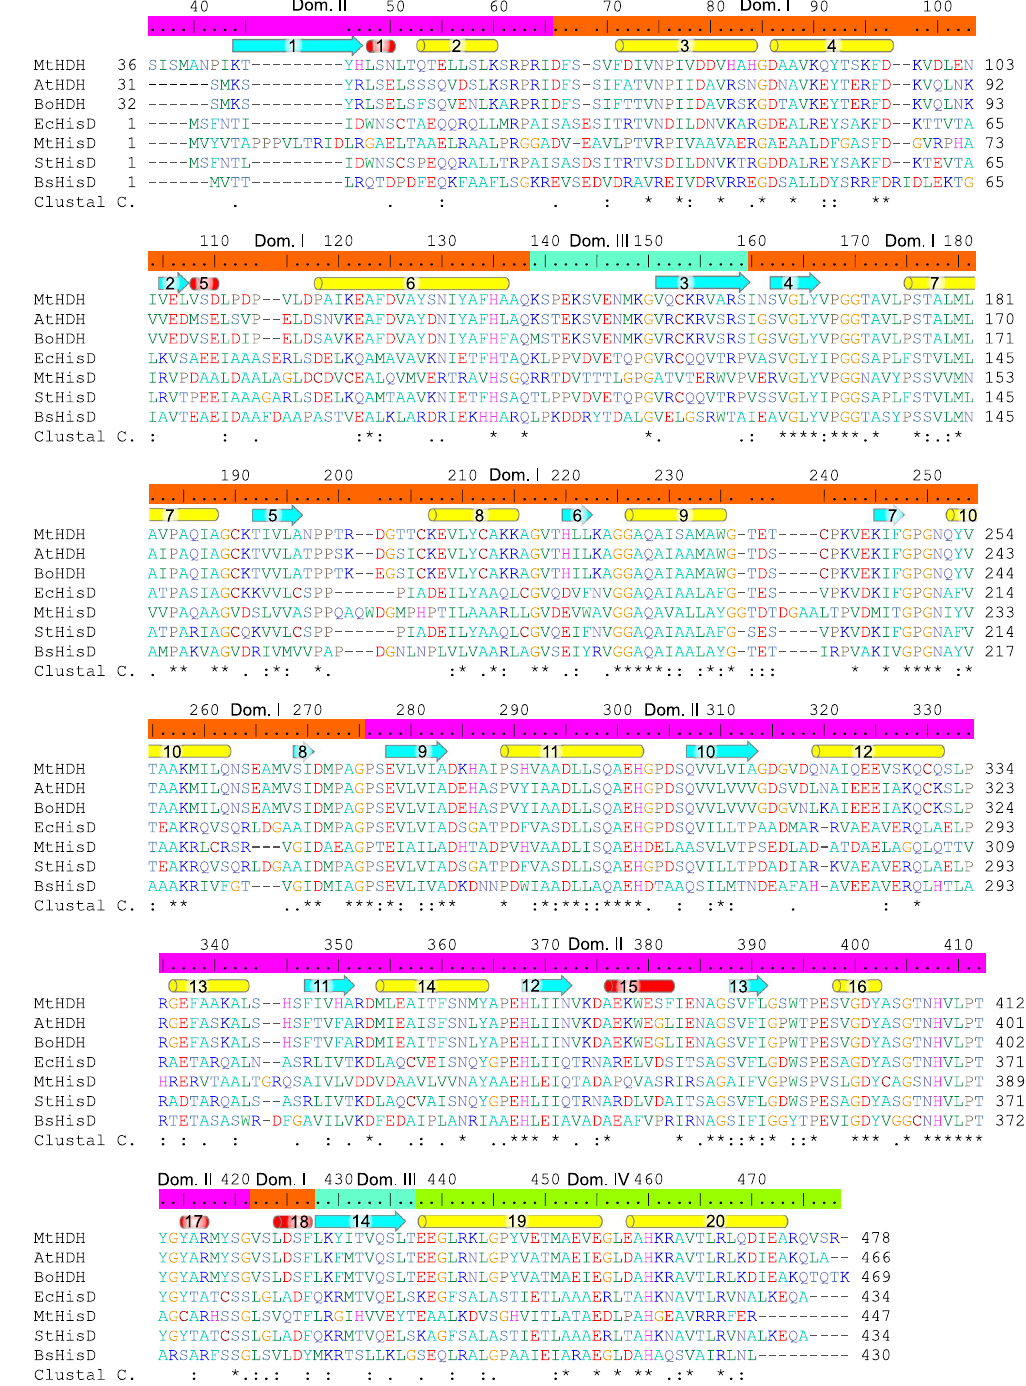
Figure 2. Sequence alignment of HDH enzymes from various sources: Mt HDH, Medicago truncatula [UniProt accession number: G7IKX3]; At HDH, Arabidopsis thaliana [Q9C5U8-1]; Bo HDH, Brassica oleracea [P24226]; Ec HisD, Escherichia coli (strain K12) [P06988]; Mt HisD, Mycobacterium tuberculosis (strain H37Rv) [P9WNW9]; St HisD, Salmonella typhimurium (strain LT2) [P10370]; Bs HisD, Brucella suis biovar 1 (strain 1330) [Q8G2R2]. For clarity of the alignment, the N-terminal signal peptides of At and Bo enzymes were truncated at positions 31 and 32, respectively, which correspond to Pro42 in Mt structure, which is the first residue visible in the electron density. Domains of MtHDH are coloured: I, orange; II, magenta; III, turquoise; IV, chartreuse. Elements of the secondary structure are: α -helices, yellow; 3 10 helices, red; β -strands, cyan. Helices are numbered consecutively, regardless of the